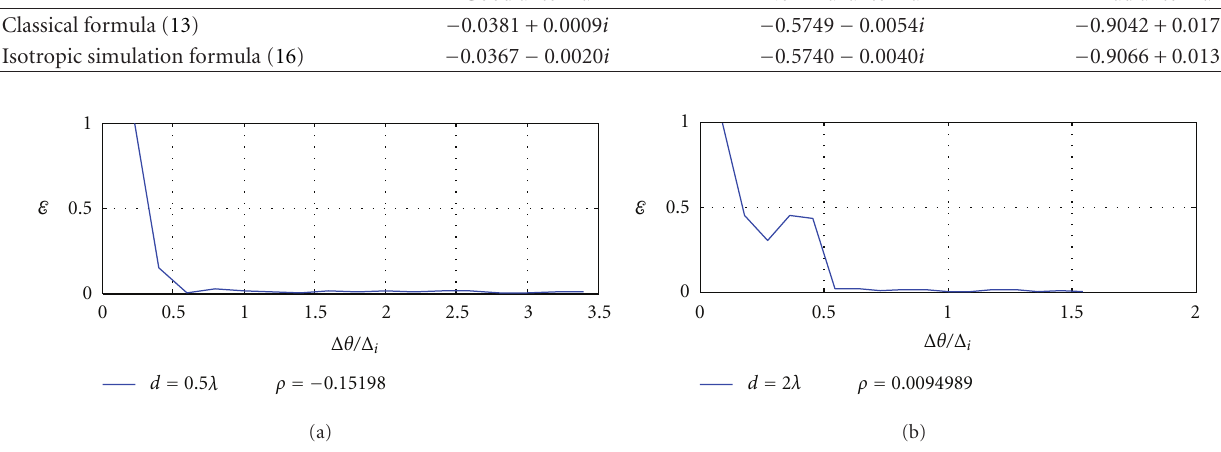
Figure 5: The error E in (19) as a function of Δ θ/ Δ i where Δ θ = π/ ( N + 1). N is computed from (5) with γ = 2. Large values of Δ θ/ Δ i correspond to dense plane-wave distributions in the isotropic